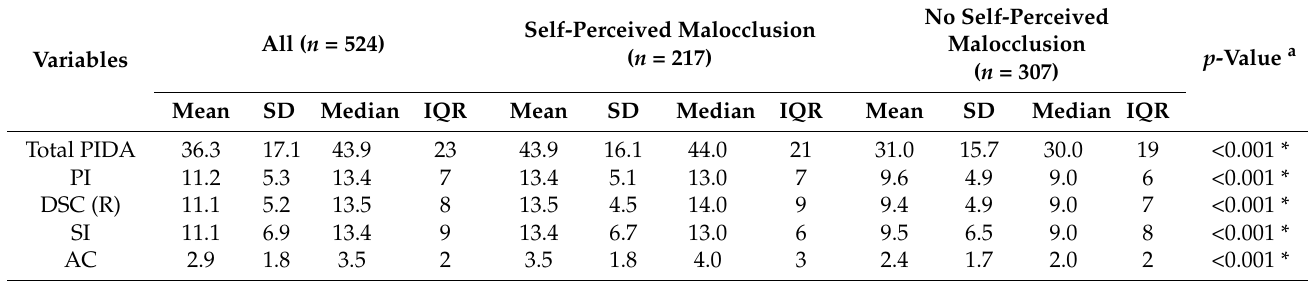
Table 3. Distribution of scores for total PIDA and its domains amongst the study subjects and by self-perceived malocclusion status ( N =